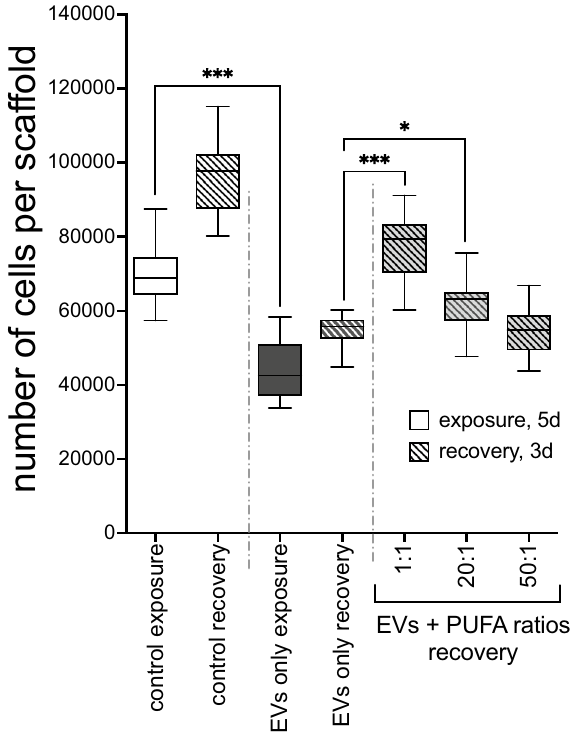
Figure 5. DHA-rich PUFA ratios restored the EV-induced suppression of recellularization on lung matrix scaffolds. Human lung scaffolds were seeded with HBEC, challenged with 50 × 10 9 EVs/mL for 5d (“exposure,” solid bars) then allowed to recover in the presence of PUFA ratios for an additional 3d (“recovery,” hatched bars). DE-derived EVs hindered the repopulation of scaffolds during both exposure and recovery, while DHA-